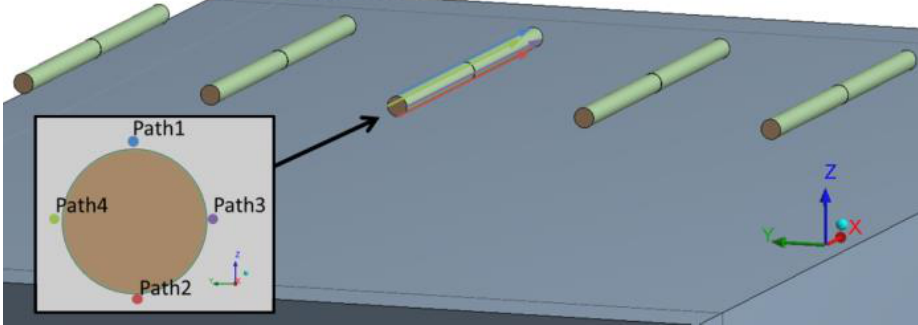
Figure 7. Position of paths led in concrete slab near defective dowel.